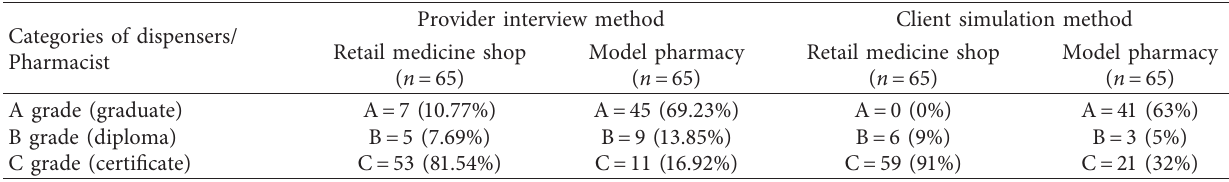
Table 2: Grades of pharmacists present in the pharmacies.